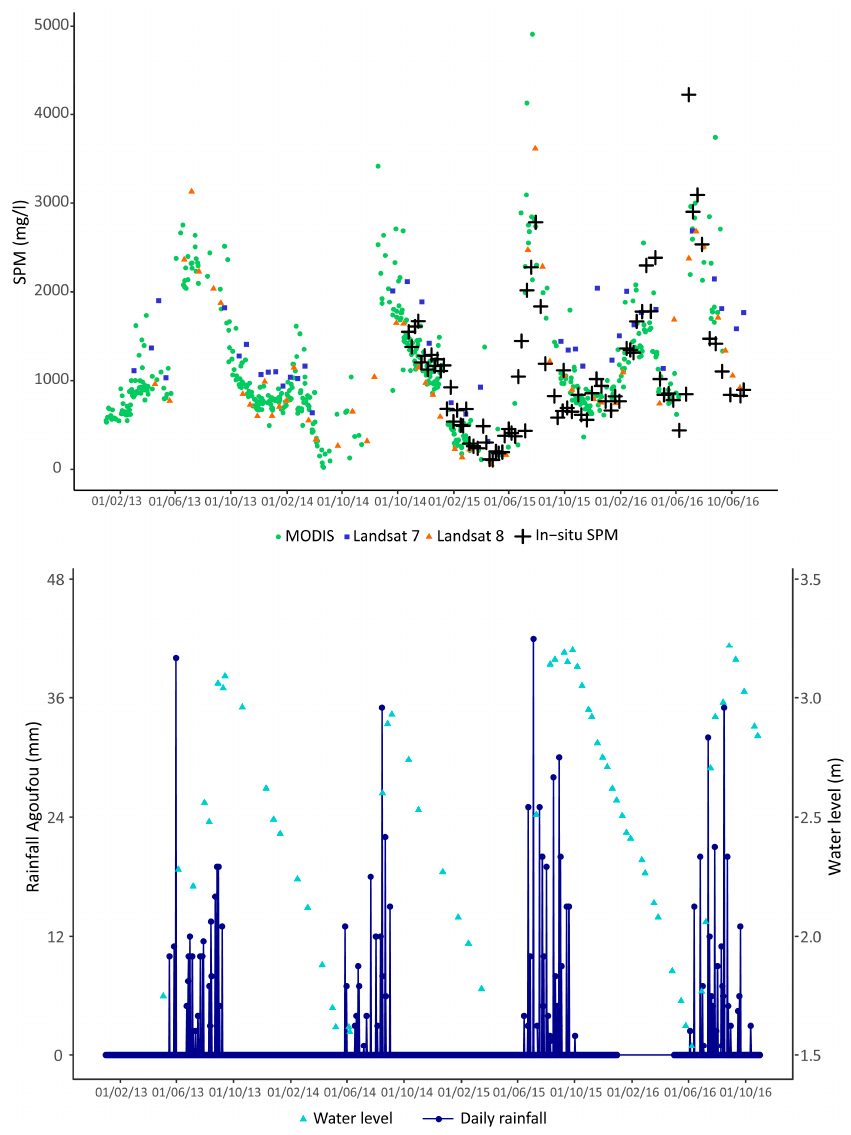
Figure 5. Top: SPM time series derived from MODIS, Landsat 7 and Landsat 8, and in-situ SPM. Bottom: time series of precipitation (Agoufou raingauge), and in-situ water level of the Agoufou Lake.